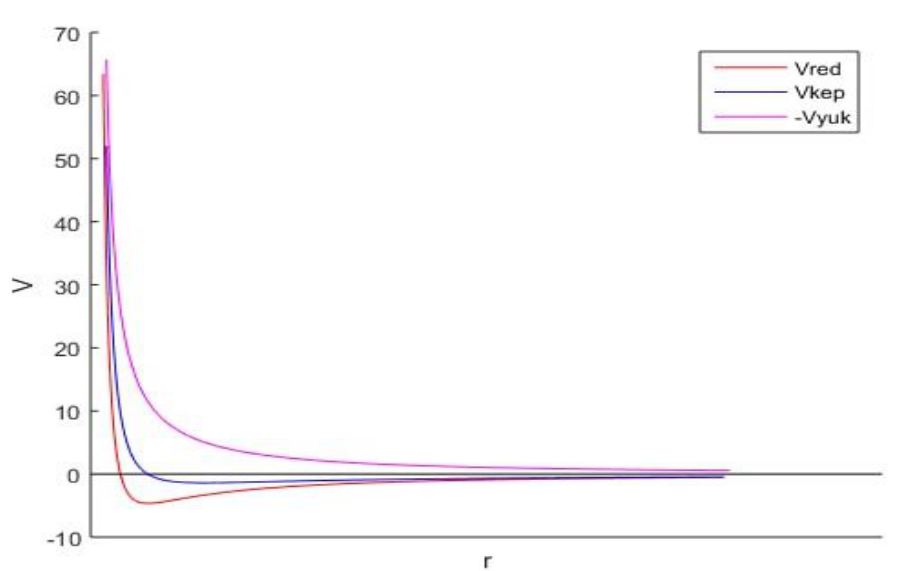
(cid:12) (cid:12) (cid:12) (cid:12) − α K e − r λ (cid:12) (cid:12) ), whereas the blue line represents r